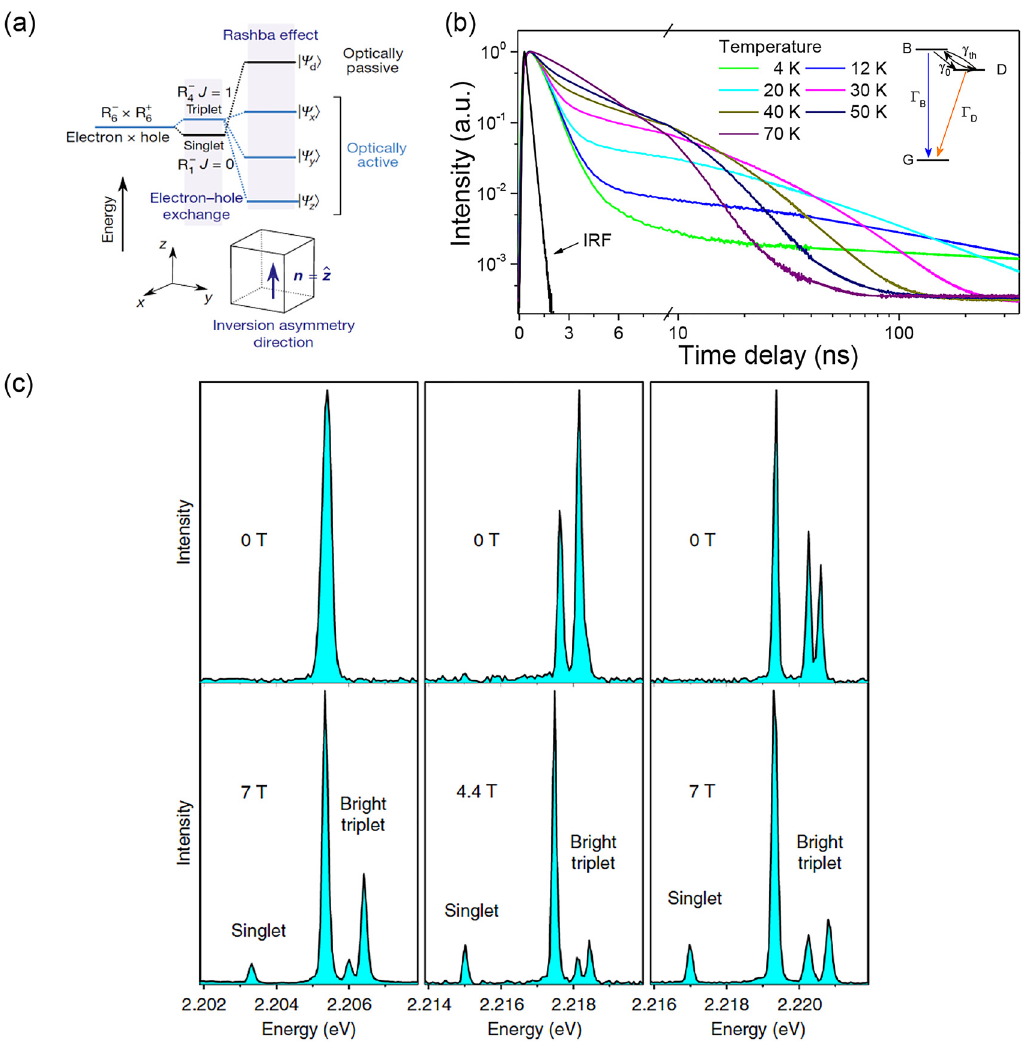
Figure 12: (a) Theoretically predicted fine level structures of band-edge exciton considering the electron-hole exchange interaction and the Rashba effect in perovskite nanocrystals. Reproduced with permission [154]. Copyright 2018, Nature Publishing Group. (b) TRPL curves of CsPbBr 3 nanocrystals recorded at different temperatures. The inset depicts a three-level model with the ground state (G), bright state (B) and darkstate(D).Reproducedwithpermission[158].Copyright2018,AmericanChemicalSociety.(c)Theone-,two-,andthree-peakedPLspectra measured from three different FAPbBr 3 nanocrystals at 4 K in zero magnetic fi eld (upper) and the corresponding four-peaked PL spectra measured at 4 K in magnetic fi eld as marked (lower), respectively, revealing the lowest-energy singlet dark-exciton peak. Reproduced with permission [159]. Copyright 2019, Nature Publishing